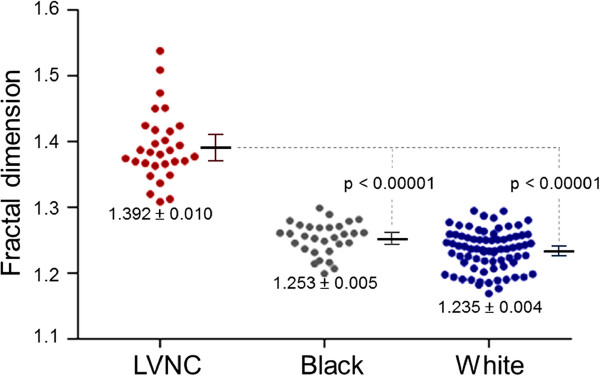
Maximal apical FD in all subjects studied. Scatter plots show the distribution of FD in the apical third of the ventricle for all subjects studied. Error bars representing mean values (thick black lines) and upper and lower 95% CI (whiskers) are also shown. There was no overlap in maximal apical FD: no LVNC patient had a maximal apical FD < 1.309 (n = 30); all healthy whites had a maximal apical FD < 1.295 (n = 75) and all healthy blacks had a maximal apical FD < 1.299 (n = 30). CI = confidence interval; other abbreviations as in Figure 1.